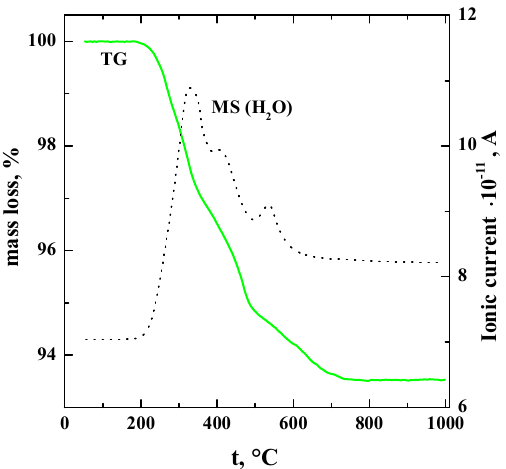
Figure 6. The TG − and MS − data for the composition Ba 1.1 La 0.9 Y 0.5 In 0.5 O 3.95. Figure 6. The TG− and MS−data for the composition Ba 1.1 La 0.9 Y 0.5 In 0.5 O 3.95.